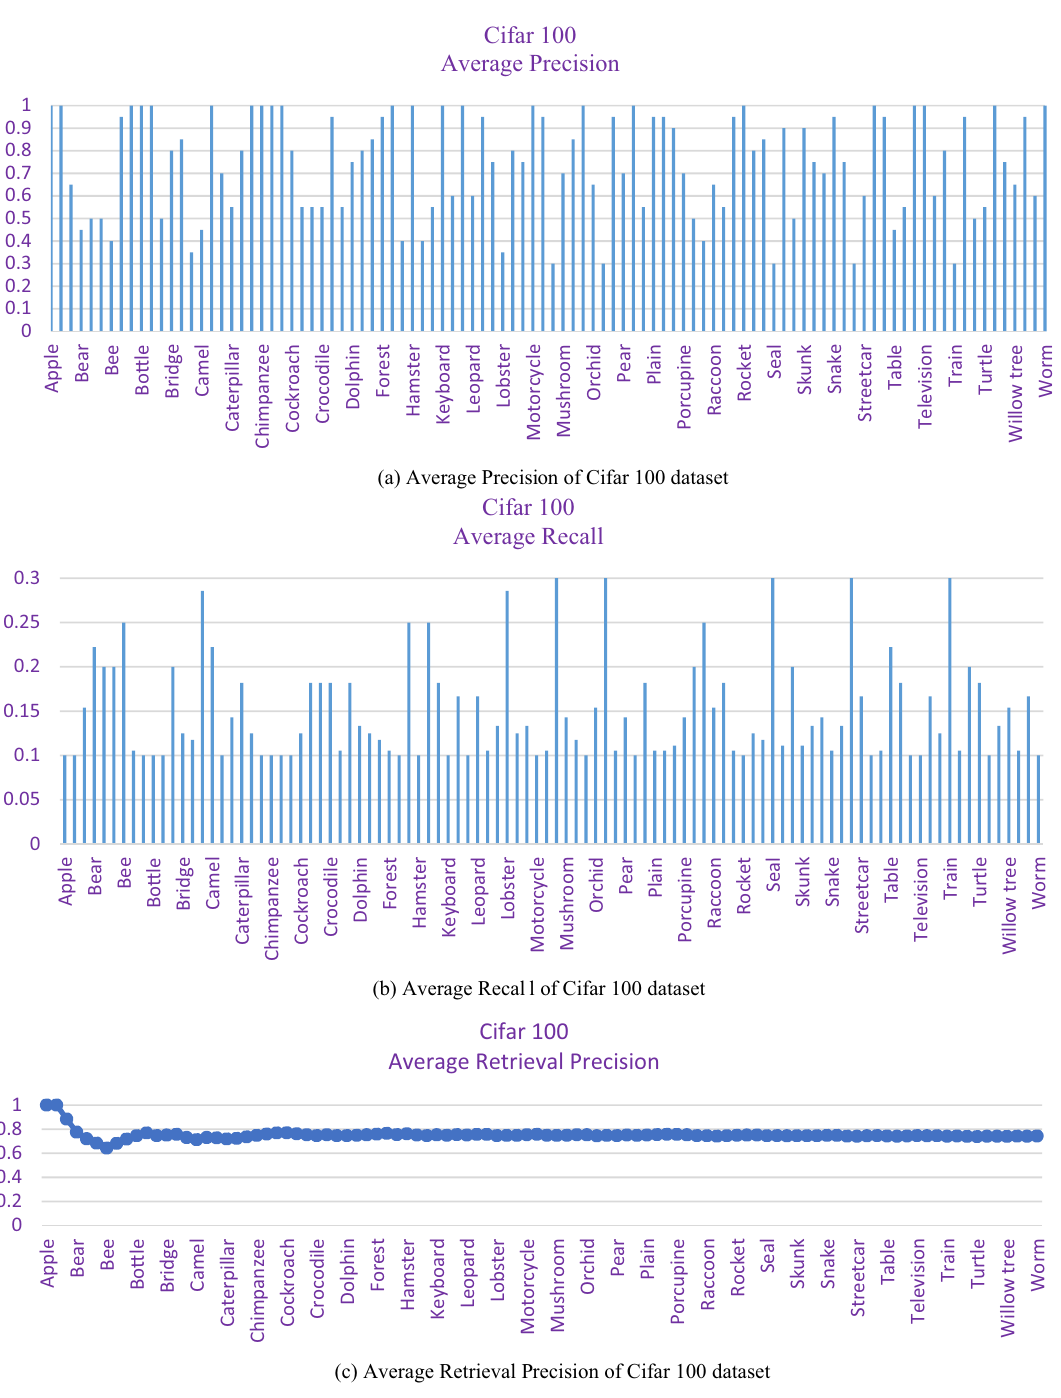
Fig. 7 a Average precision of Cifar 100 dataset. b Average recall of Cifar 100 dataset. c Average retrieval precision of Cifar 100